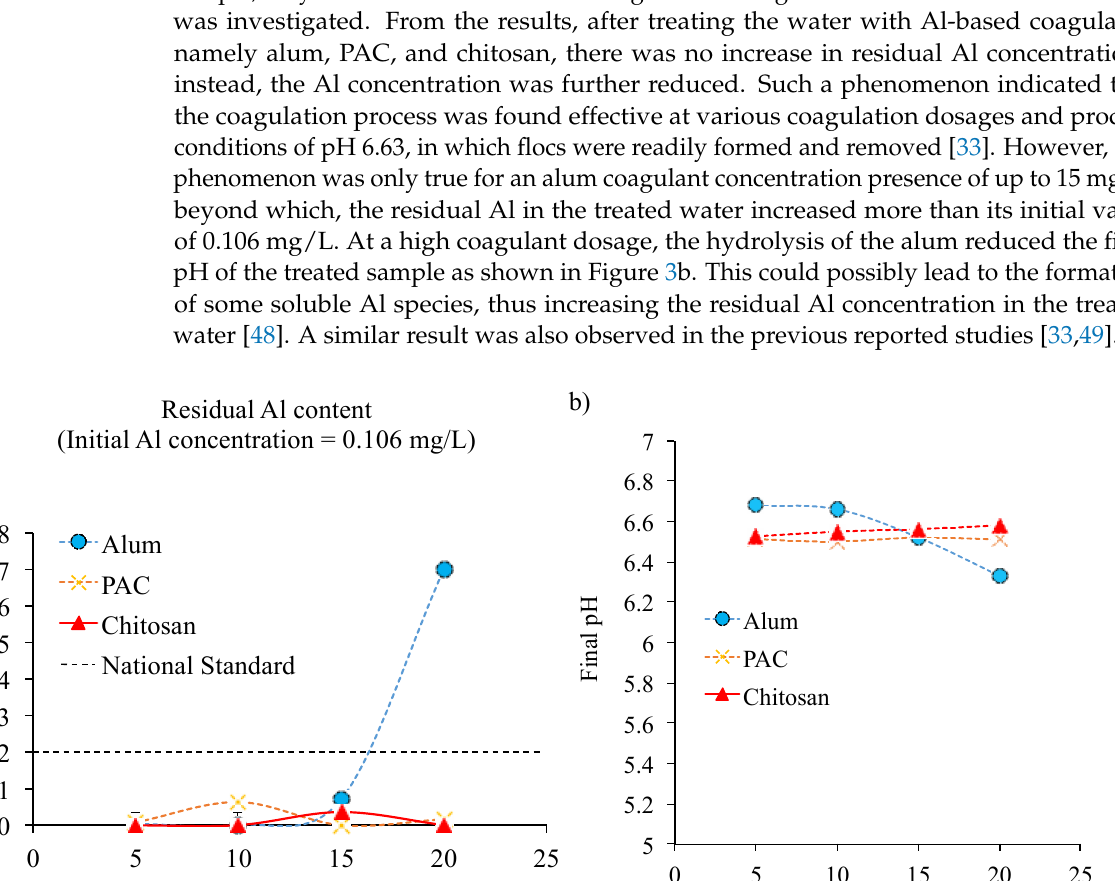
Figure 2. Illustration of coagulation–flocculation mechanisms of chitosan and Al-based coagulants (non-polymeric and polymeric coagulant) .